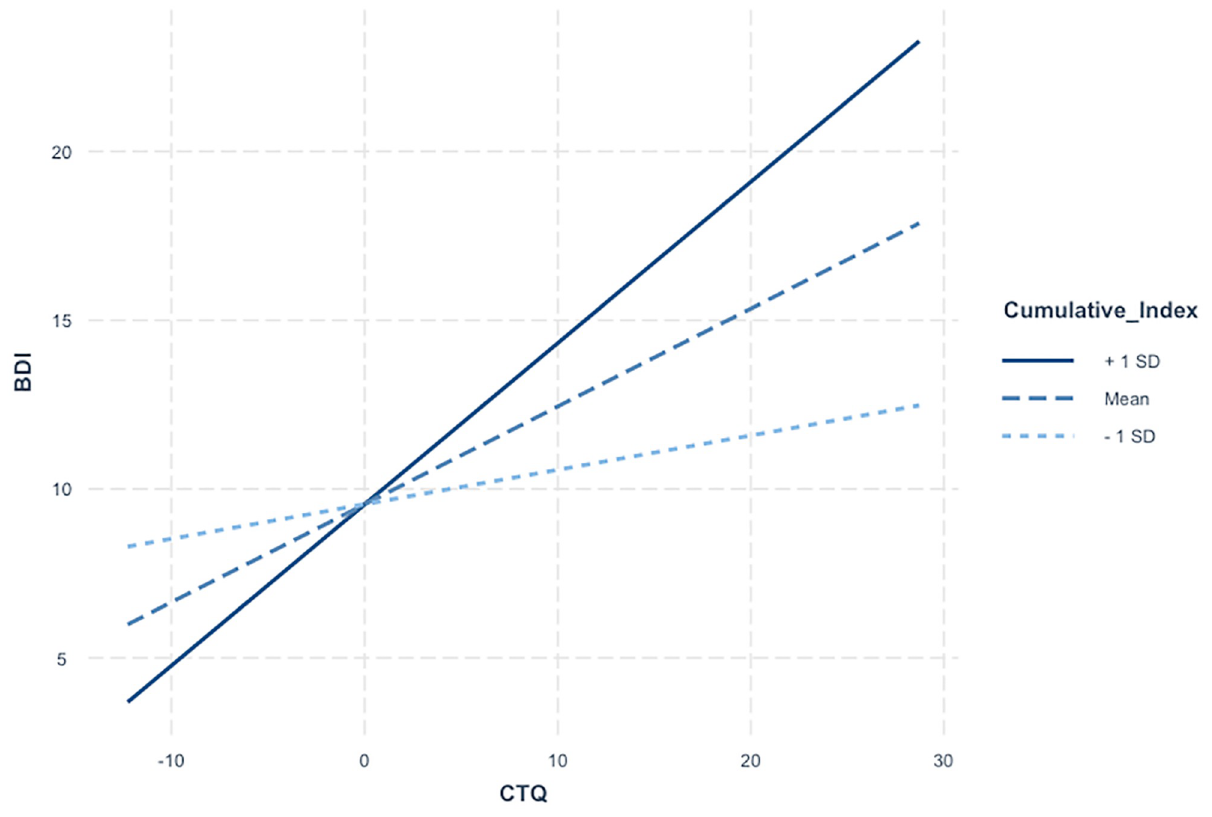
Fig 2. A visual representation of the association between child maltreatment and depressive symptoms according to a cumulative index of methylation. Fig 2 depicts the conditional association between maltreatment experiences and depressive symptoms according to increasing DNAm levels, depicted in three equal